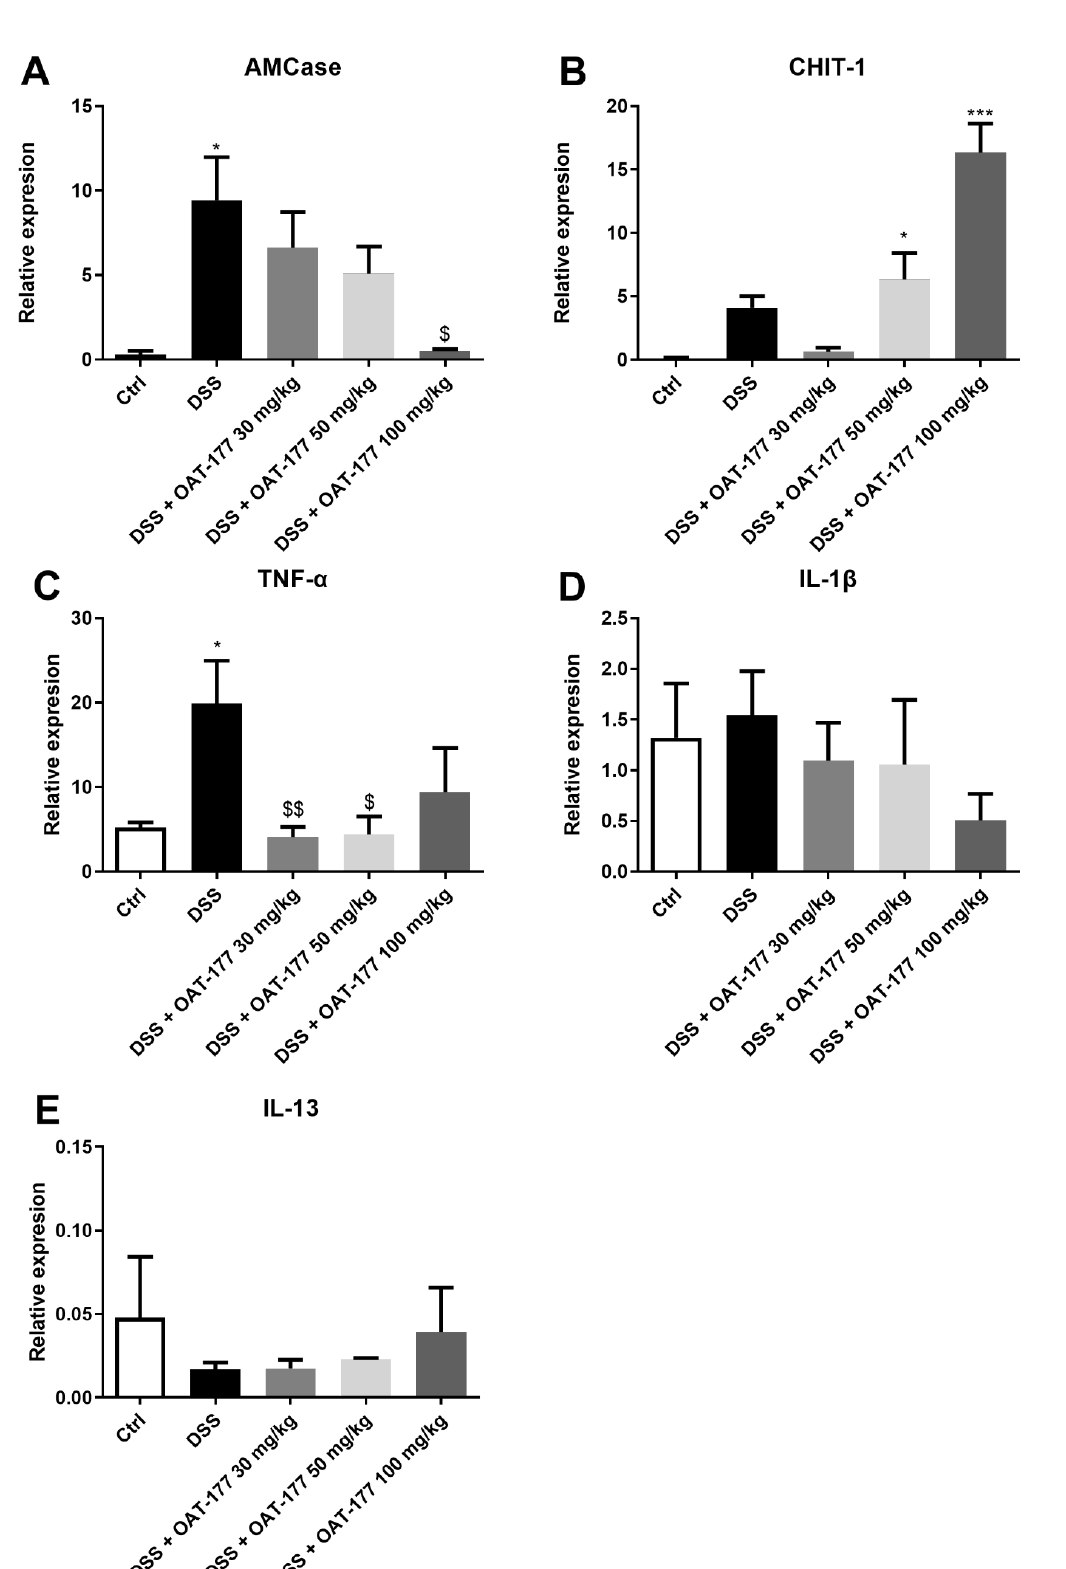
Figure 3. AMCase ( A ), Chitinase 1 ( B ), and selected cytokine: TNF- α ( C ), IL-1 β ( D ), and IL-13 ( E ) mRNA expression in the mouse colon for control, DSS-only treated mice, and mice with DSS- induced colitis treated with OAT-177 at doses of 30, 50, and 100 mg/kg (p.o.) in the short-term therapeutic protocol. *** p < 0.001, * p < 0.05 vs. control group; $$ p < 0.01, $ p < 0.05 vs. DSS-only treated